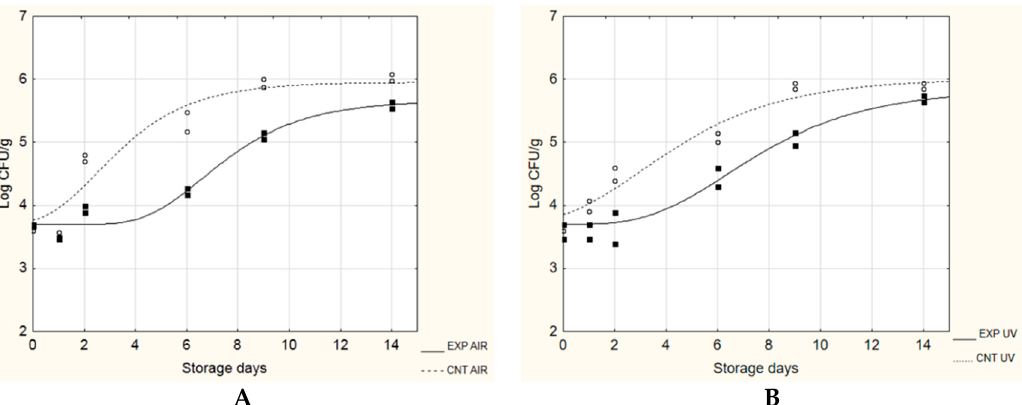
Figure 4. Evolution of Ps. fluorescens during the challenge test at 15 °C. EXP, cheeses stored with probiotic biofilms; CNT, cheeses stored without probiotic biofilm. ( A ), AIR packaging; ( B ), under vacuum packaging (UV).